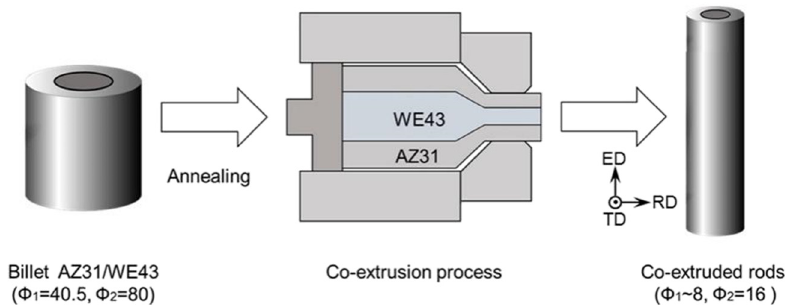
Figure 1: Schematic of the AZ31/WE43 bimetallic composite rod prepared by hot - press di ff usion and co - extrusion [ 80 ]